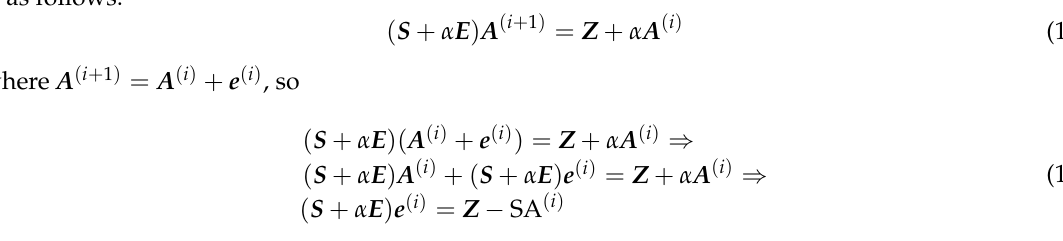
of every iteration.